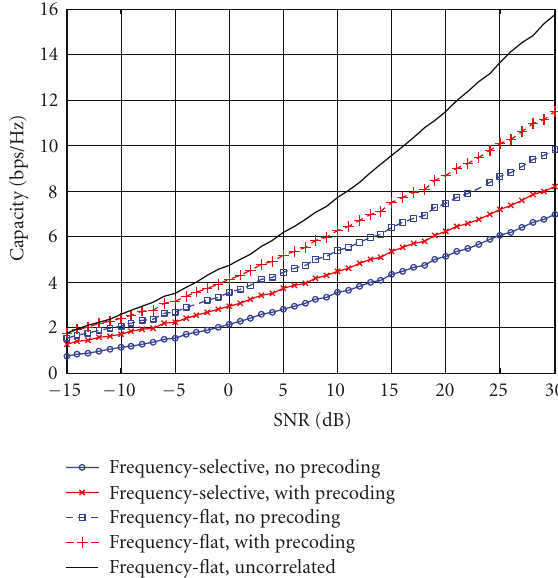
Figure 4: Performance comparison in fully correlated channels. channel paths (i.e., M = 2,4 and L = 2,4). Figure 5 shows the ergodic capacity of the system for di ff erent eigenvalue spreads ( λ max /λ min ): 1 (no correlation), 2 (partial correla- tion), and ∞ (full correlation). The results clearly indicate that the capacity decreases with an increase in eigenvalue spread of the spatial correlation